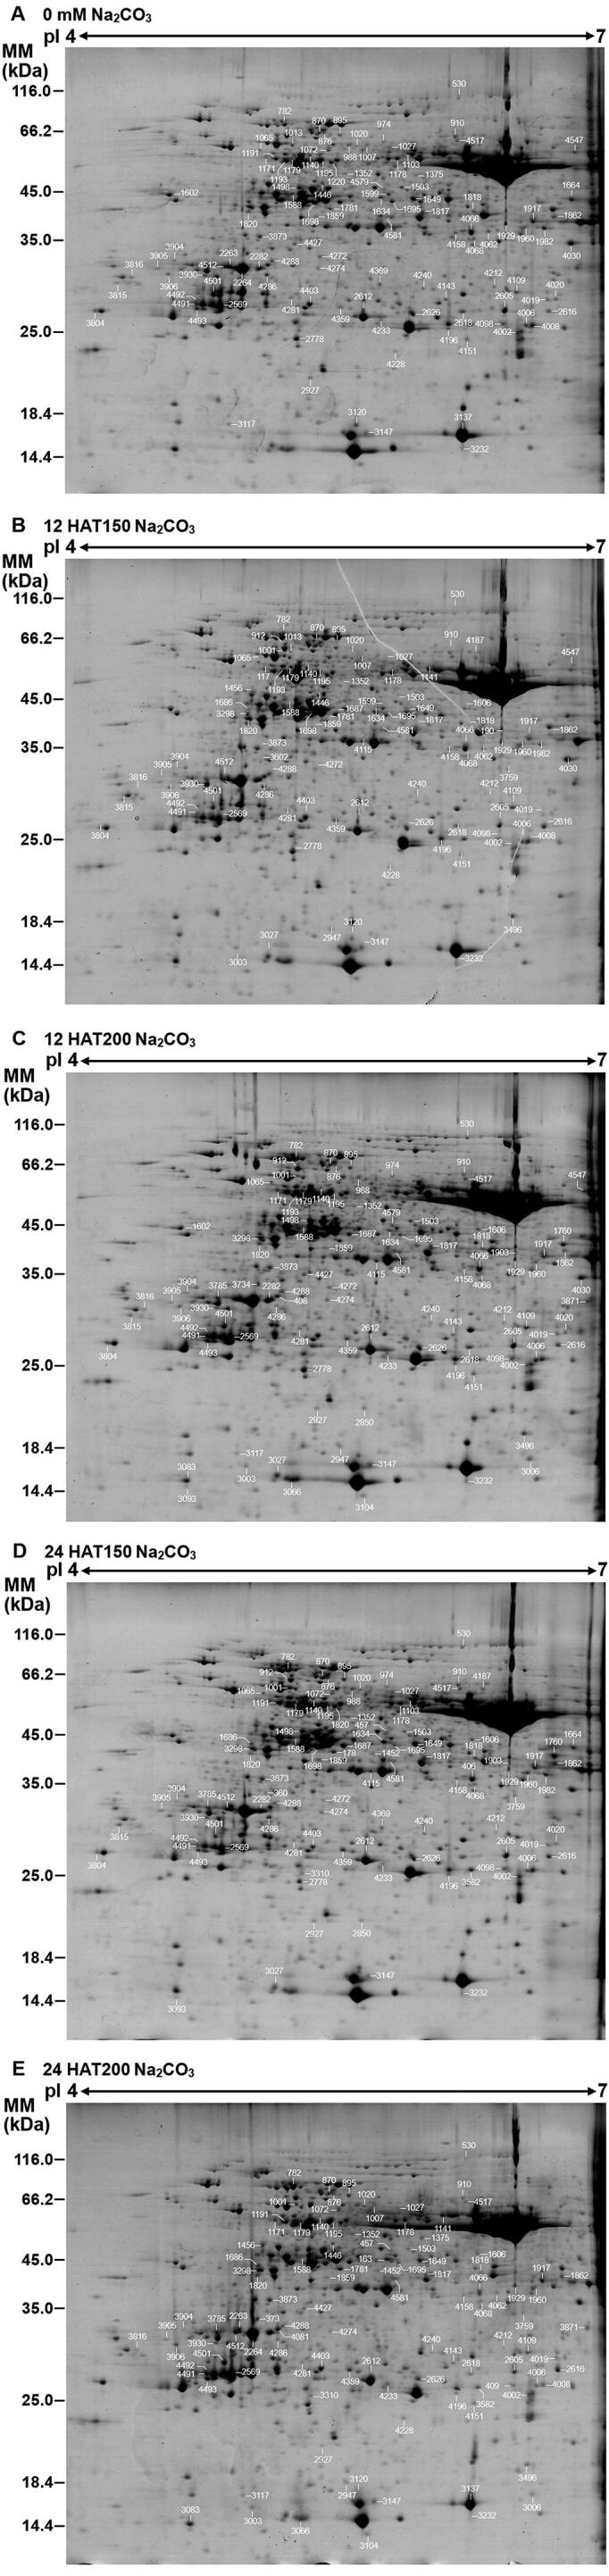
Coomassie brilliant blue-stained two-dimensional gel electrophoresis gels Protein was extracted from leaves of Puccinellia tenuiflora under Na2CO3 treatment conditions and separated on 24 cm IPG strips (pH 4-7 linear gradient) using isoelectric focusing in the first dimension, followed by 12.5% SDS-PAGE gels in the second dimension. A total of 104 Na2CO3-responsive proteins identified by mass spectrometry were marked with numbers on the representative gels. Detailed information can be found in Supplementary Table S2. A. 0 mM Na2CO3. B. 150 mM Na2CO3 for 12h (12 HAT150). C. 200 mM Na2CO3 for 12h (12 HAT200). D. 150 mM Na2CO3 for 24h (24 HAT150). E. 200 mM Na2CO3 for 24h (24 HAT200).